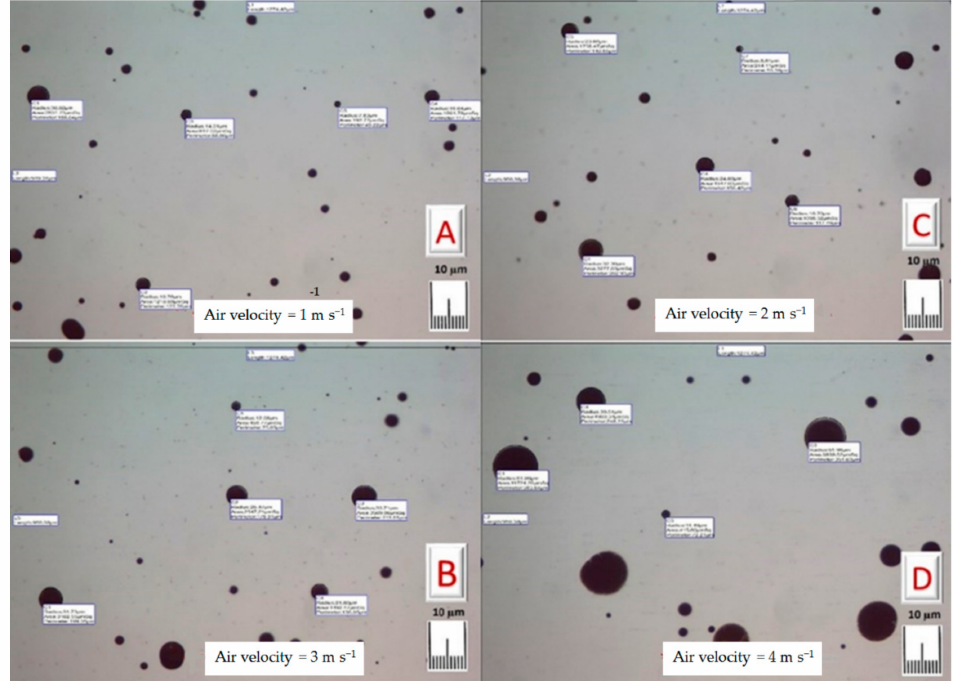
Figure 7. Images of the droplets captured using a digital camera of an optical microscope at different air velocities at the outlet of the ultrasonic humidifier ducts of 1 m s − 1 ( A ), 2 m s − 1 ( B ), 3 m s − 1 ( C ), and 3 m s − 1 ( D ) using 10 ultrasonic transducers with a frequency of 2600 kHz and an applied voltage of 48 V.